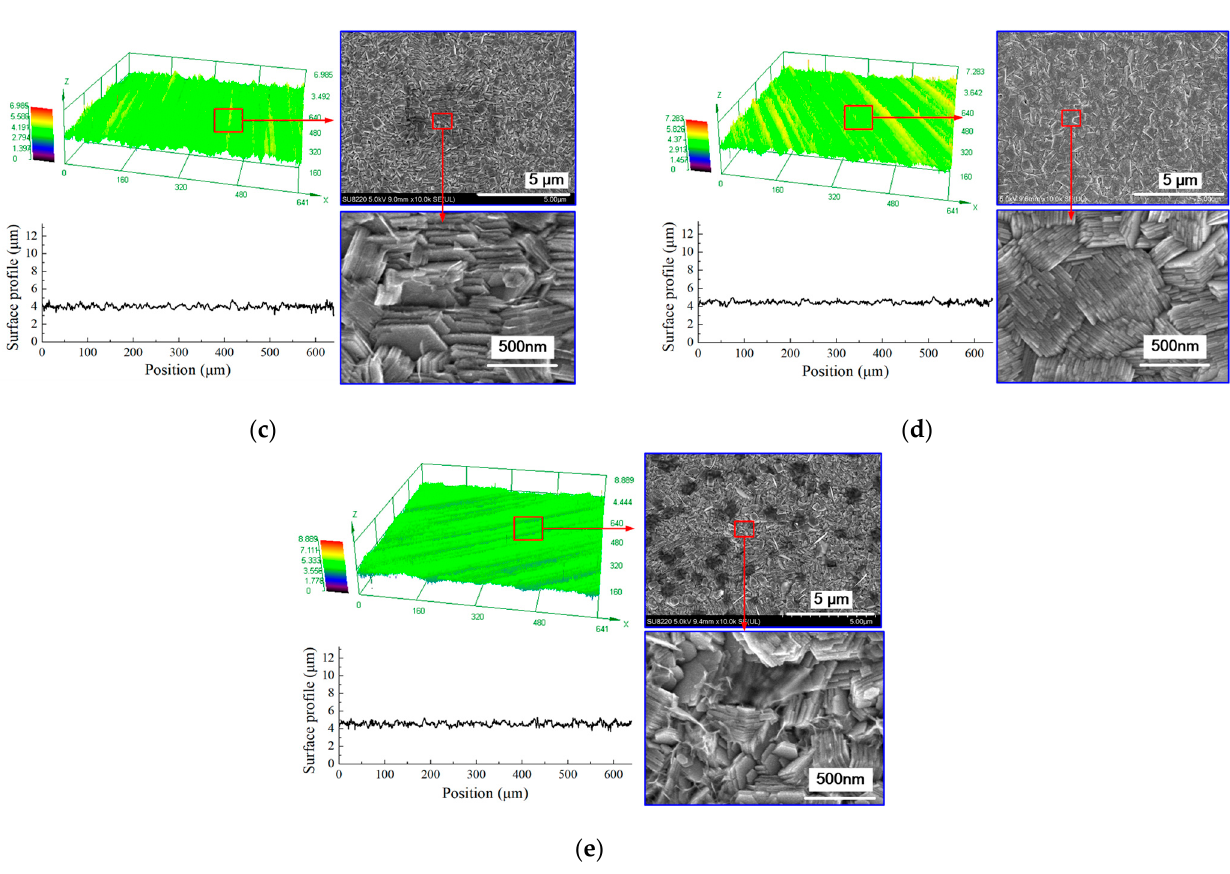
Figure 12. The effect of current density on the roughness. Figure 13 shows the X ‐ ray diffraction (XRD) patterns of the deposited coating with different current densities. Because of the thin thickness of the deposited coating, X ‐ rays could penetrate the deposited coating easily; thus, (111) and (200) are the preferred orien ‐ tations of Cu substrate in the XRD pattern. Moreover, it can be seen that (100) and (110) are the preferred orientation of the nanocrystalline zinc coating. When the current density is 0.5 A/dm 2 , it is obvious that both (100) and (110) are the preferred, which is useful to obtain a nanocrystalline zinc coating with smaller surface roughness and superior anti ‐ corrosion properties [17]. Figure 13. X ‐ ray diffraction (XRD) pattern of deposited coating with different current densities. 3.4. Tafel Polarization Curves In Section 3.3, it was observed that the grain and roughness of the deposited coating changed at different current densities. In order to further analyze their corrosion